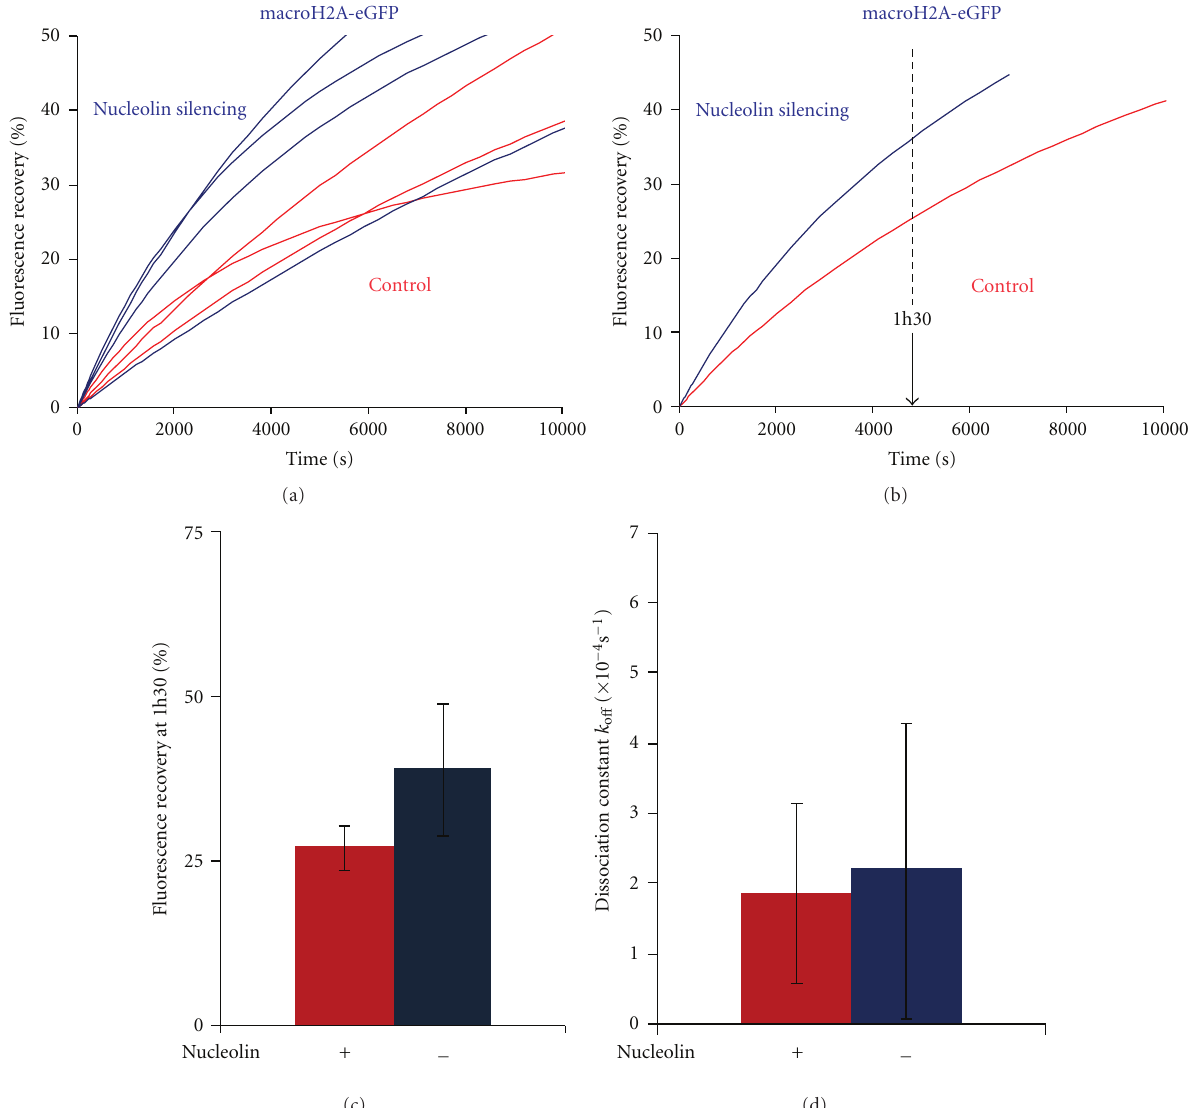
Figure 5: Nucleolin depletion leads to a faster macroH2A-eGFP fluorescence recovery kinetics. (a) Normalized fluorescence recovery (%) of macroH2A-eGFP in the nucleoplasm of control untransfected cells (red, 3 cells) and in cells transfected with siRNA against nucleolin (blue, 4 cells). Each curve represents the fluorescence recovery of a single cell. (b) Average of the normalized fluorescence curves in (a) control cell (red) and nucleolin-depleted cells (blue). (c) Comparison of the percentage of fluorescence recovery at 1h30 for control cell (red) and nucleolin-depleted cells (blue). (d) Dissociation rate constant values k o ff (s − 1 ) of macroH2A-eGFP in control untransfected (red) and nucleolin-depleted cells